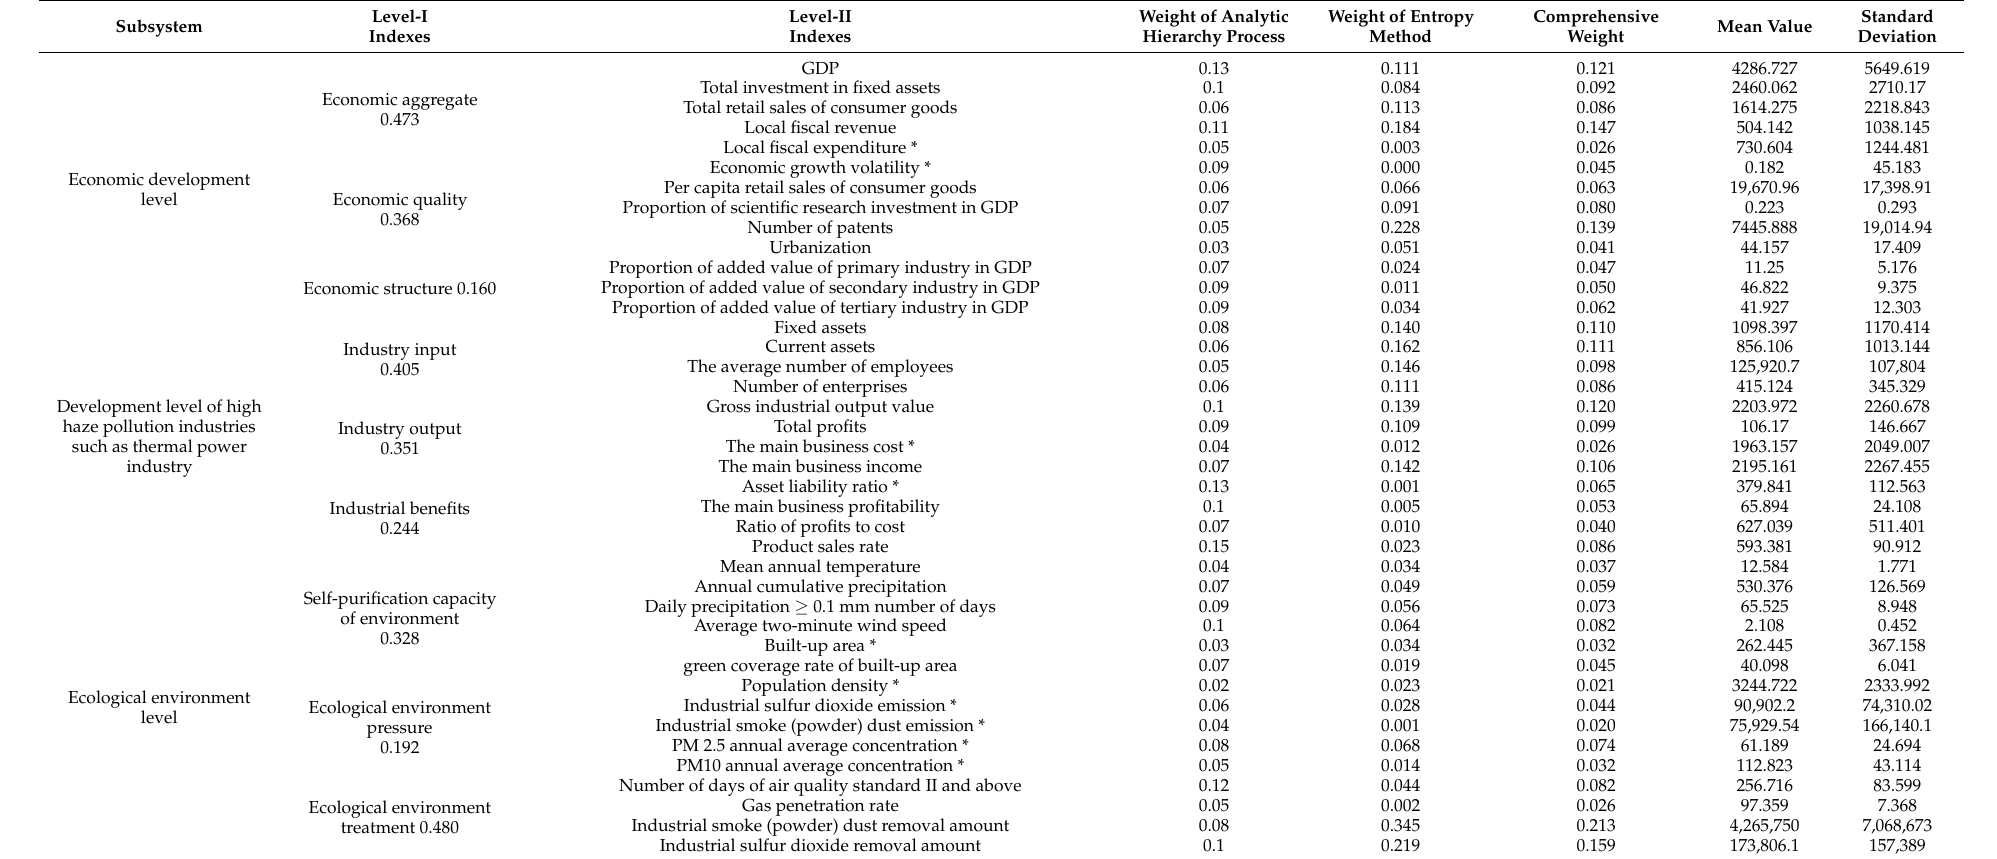
Table 1. Evaluation index system of coordinated development between high haze pollution industries, such as the thermal power industry, in the Beijing–Tianjin– Hebei region and the local